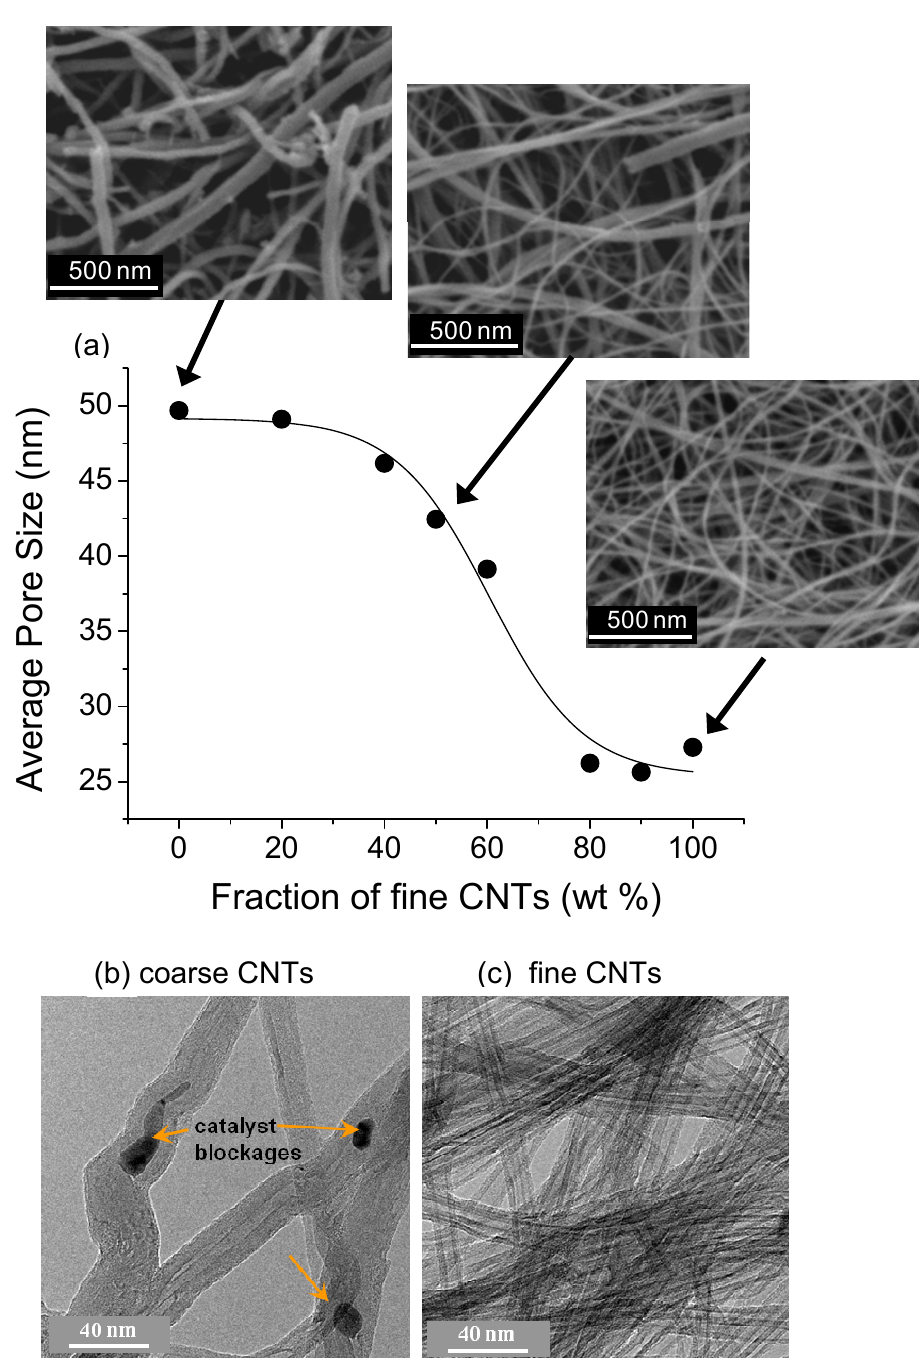
Figure 5. (a) Dependence of the Bucky-paper pore size on the ratio of “fine to coarse” carbon nanotubes. The SEM images show the Bucky-paper surface for three different ratios as indicated. (b) and (c) are TEM images (200 kV) of the coarse and fine nanotubes, respectively. The orange arrows indicate catalyst particles within the CNTs. The CNT properties are also summarized in Table